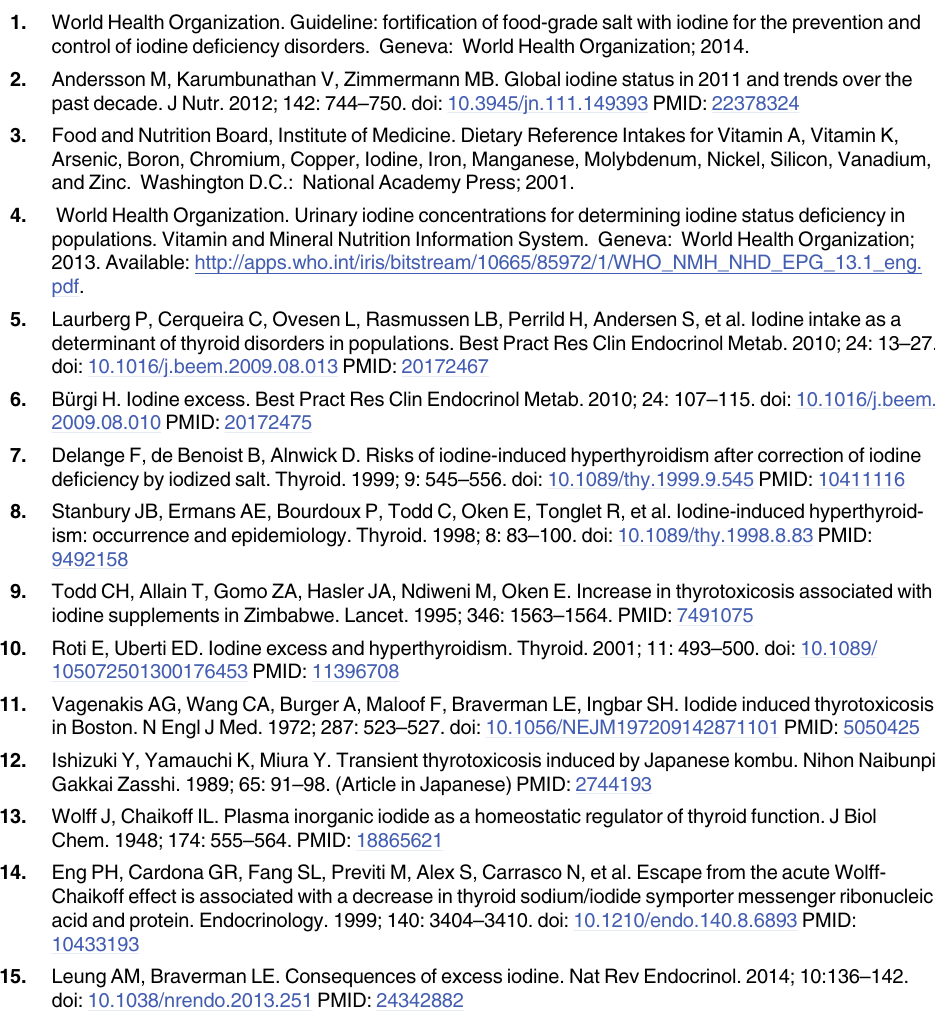
S3 Table. Risk of bias assessment